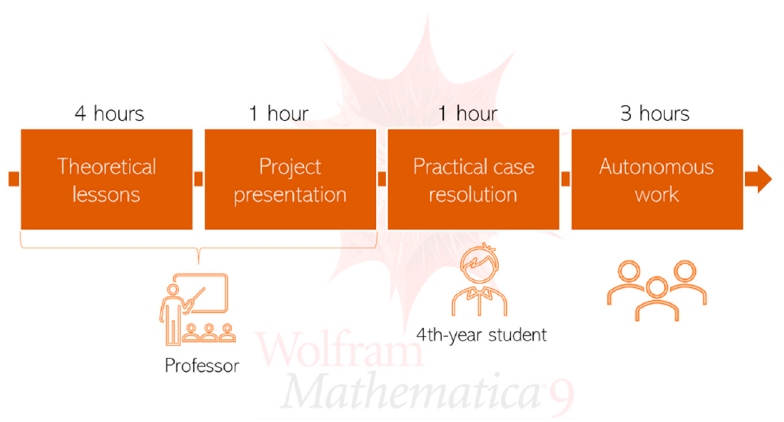
Figure 1. Workflow of the activity.